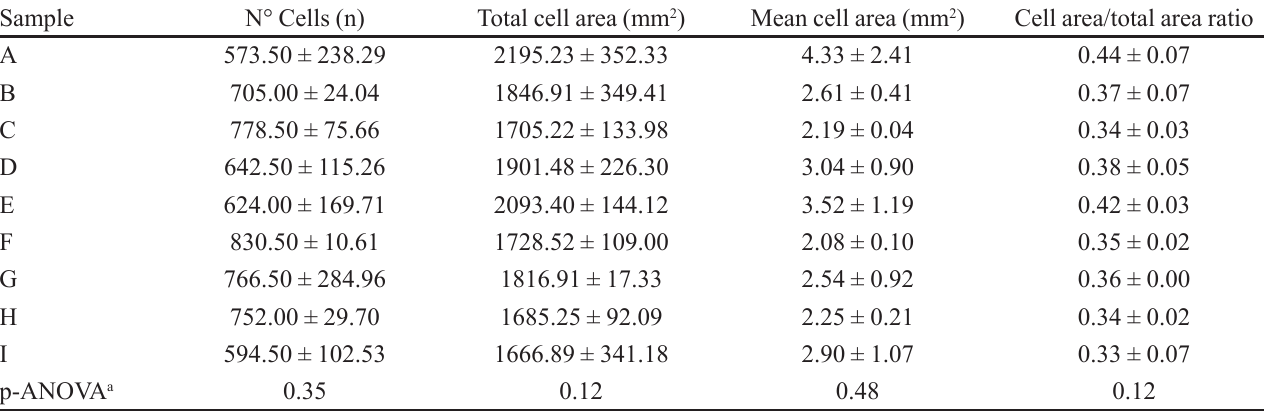
TABLE IV – Image analysis of crumb structure of panettone samples